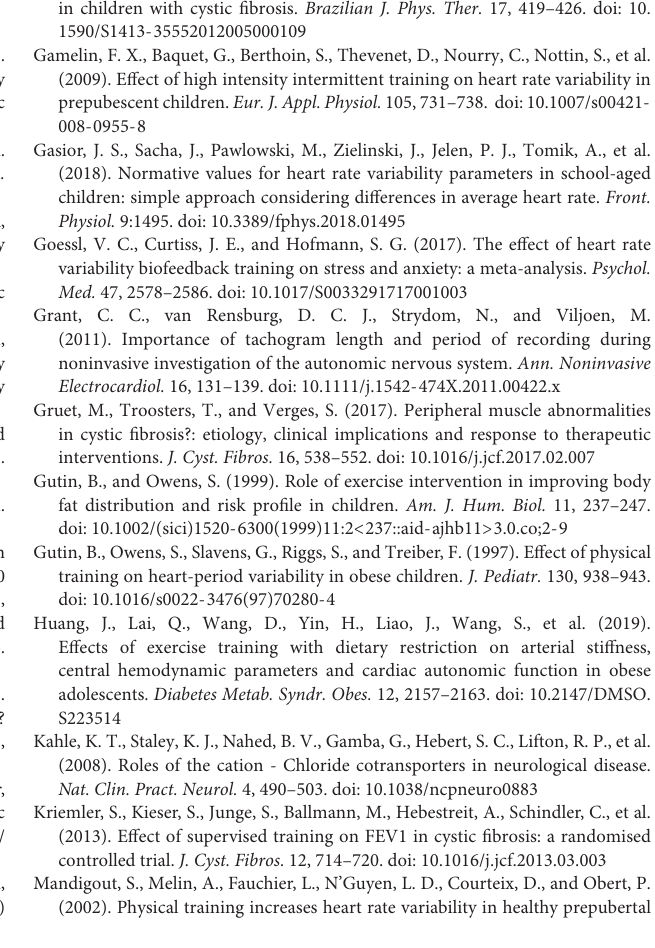
Supplementary Figure 1 | Resistance training exercises used in the intervention-training program. (A) Leg press; (B) bilateral seated row; (C) leg extension; (D) seated bench press; (E) leg